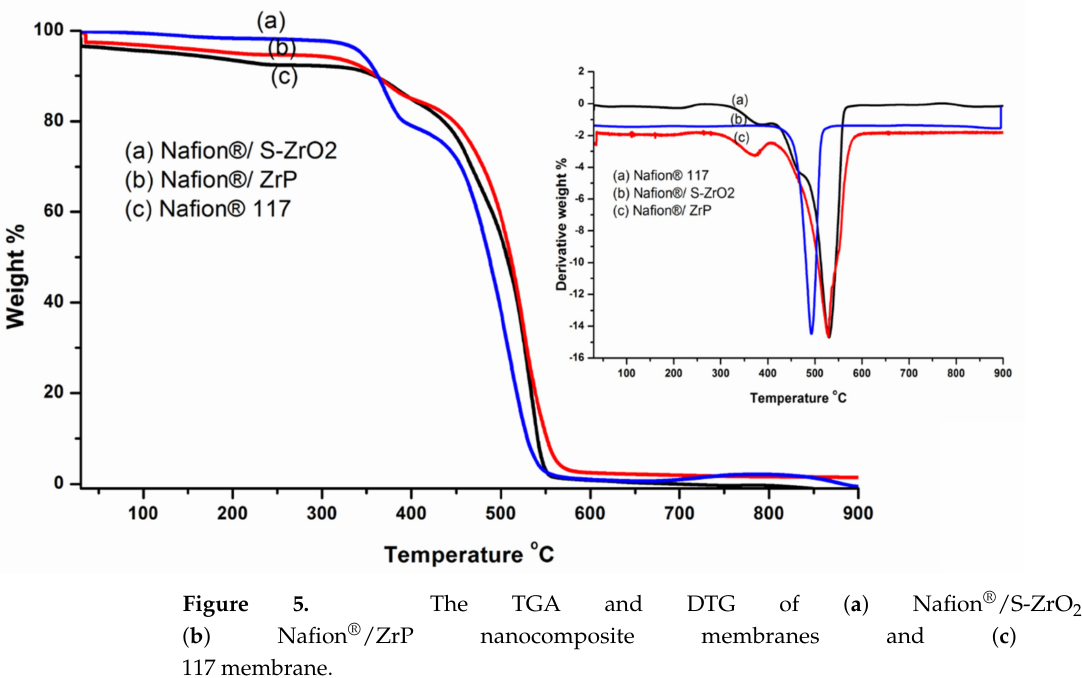
Figure 5. The TGA and DTG of ( a ) Nafion ® /S-ZrO 2 and ( b ) Nafion ® /ZrP nanocomposite membranes and ( c ) Nafion ® 117